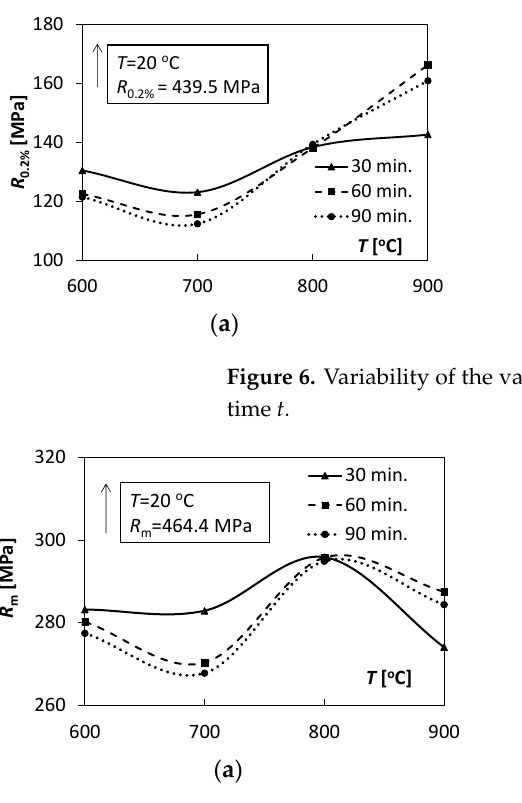
Figure 7. Dependence of the tensile strength R m on: ( a ) temperature T , ( b ) annealing time t .